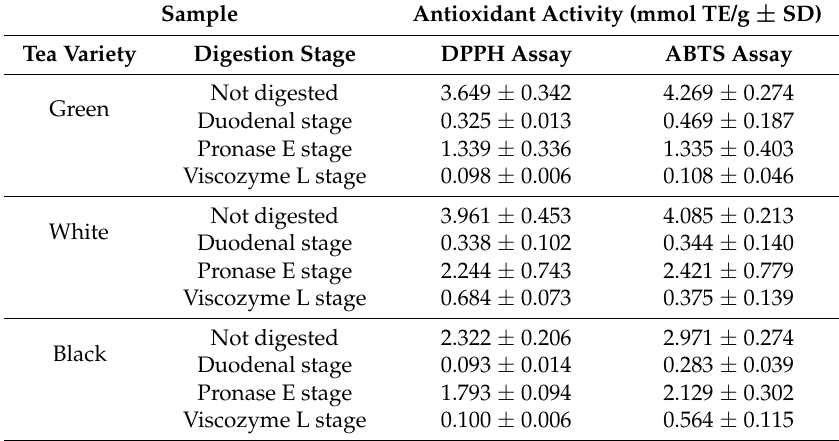
Table 4. Antioxidant activity of digested samples evaluated by DPPH and ABTS assays. Data are expressed as mean value in mmol TE/g extract ± SD (of three repetitions).